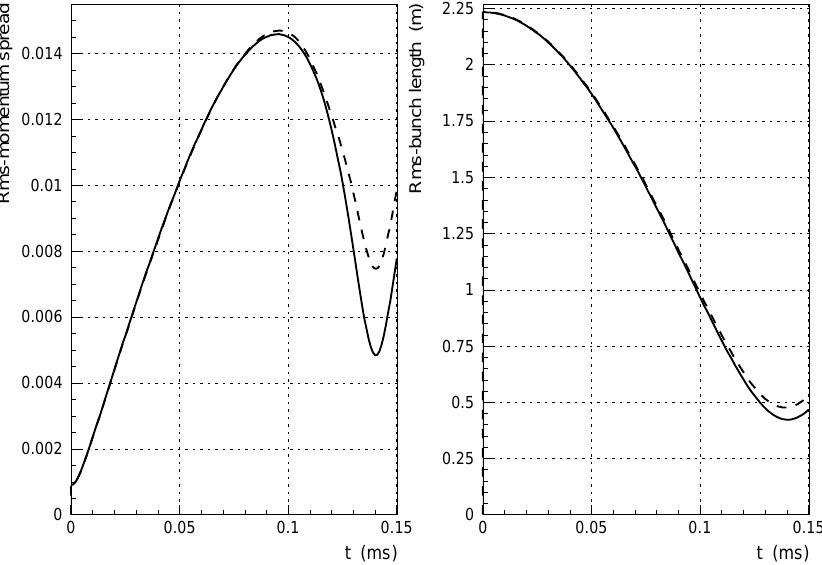
FIG. 9. Comparison of PATRIC simulation for initial parabolic and Gaussian bunch with h (cid:1) 2 0.005